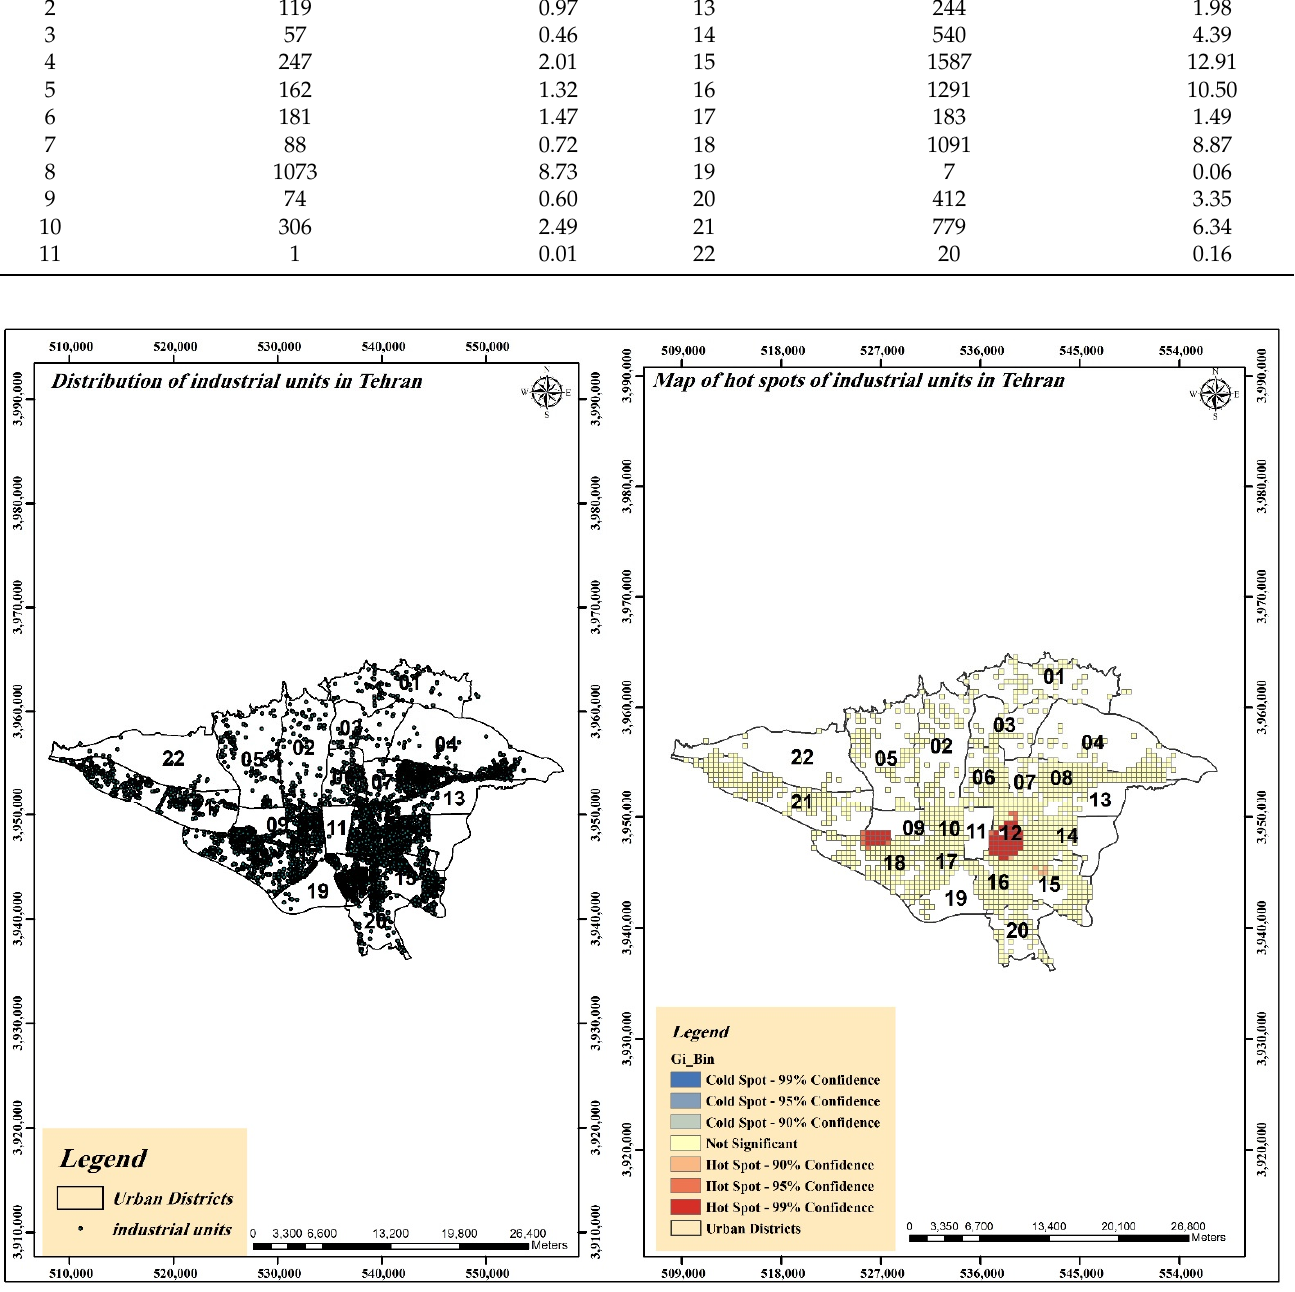
Figure 5. Status of distribution of industrial units in Tehran metropolis.